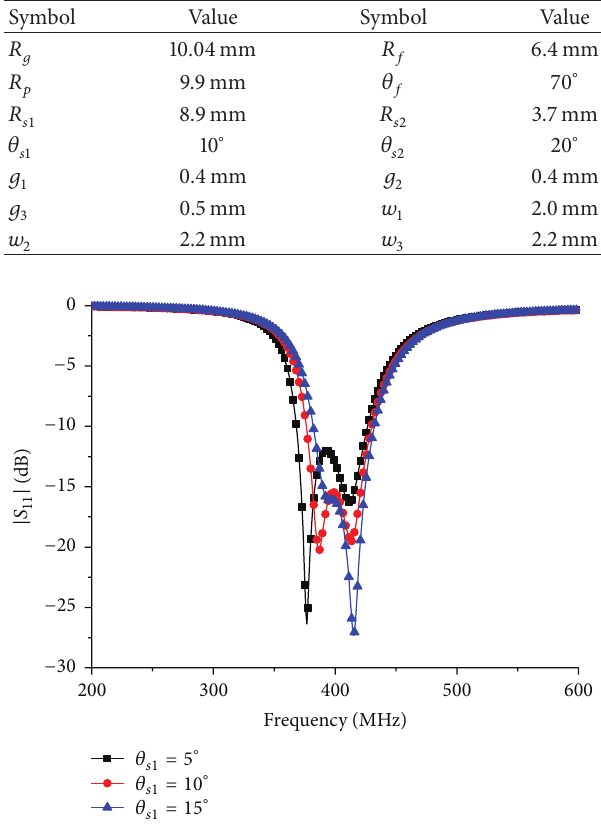
Figure 6: Comparison of |𝑆 11 | of the proposed antenna with different short positions of the split